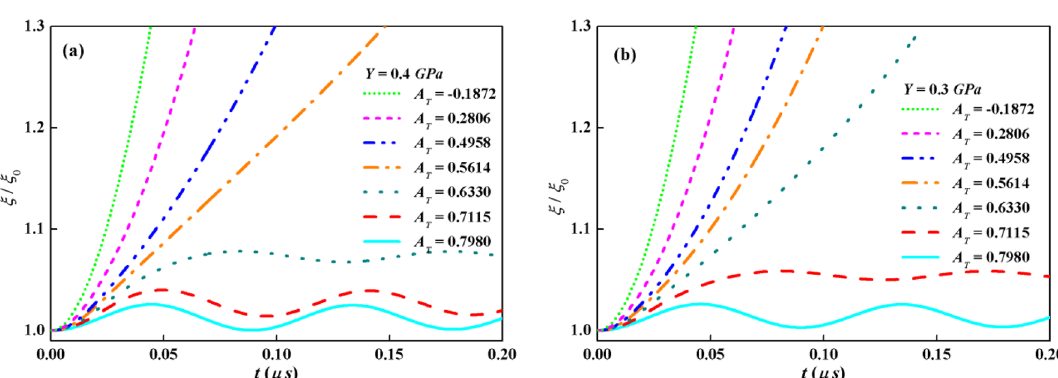
Figure 6. Growth factors vs time with A T = 0.7980, 0.7115, 0.6330, 0.5614, 0.4958, 0.2806 and − 0.1872 at different Y by analytical model: ( a ) Y = 0.4 GPa, ( b ) Y = 0.3